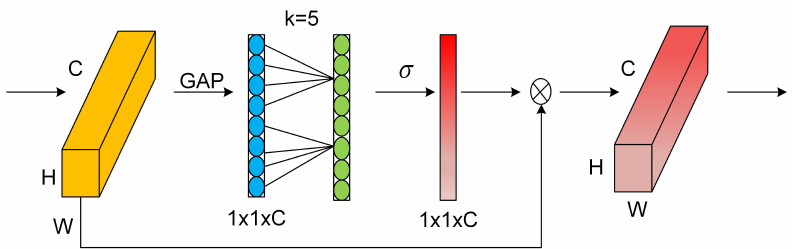
Figure 5. ECA structure schematic. Local cross-channel information interaction by 1D convolution of size k